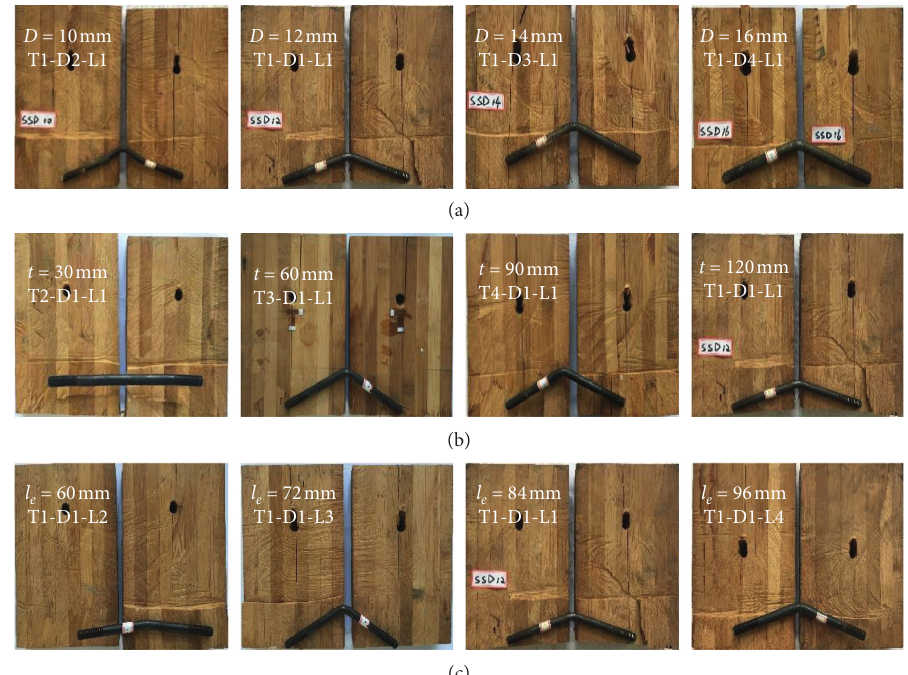
Figure 3: The yield and failure modes of the connections parallel to the grain. (a) Dowel diameter. (b) The thickness. (c) End